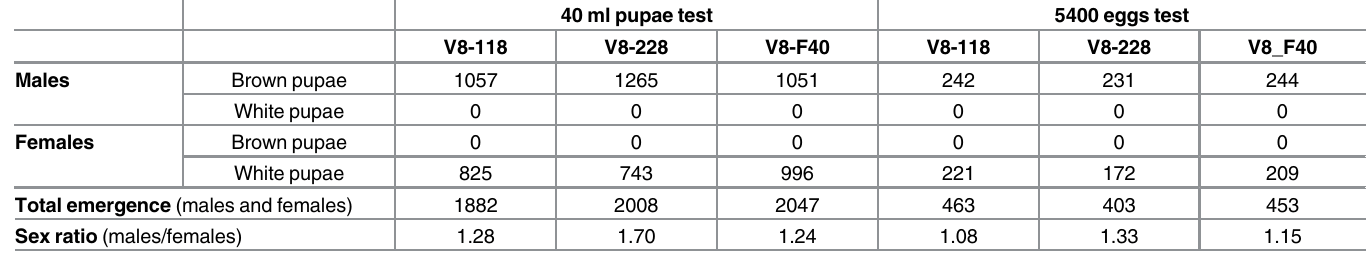
Table 1. Recovery rates from the 40 ml of pupae and 5400 eggs tests. Note that, only the data for the 900 of the 5400 eggs incubated at 25°C are included in the table. Sex ratio is also indicated.